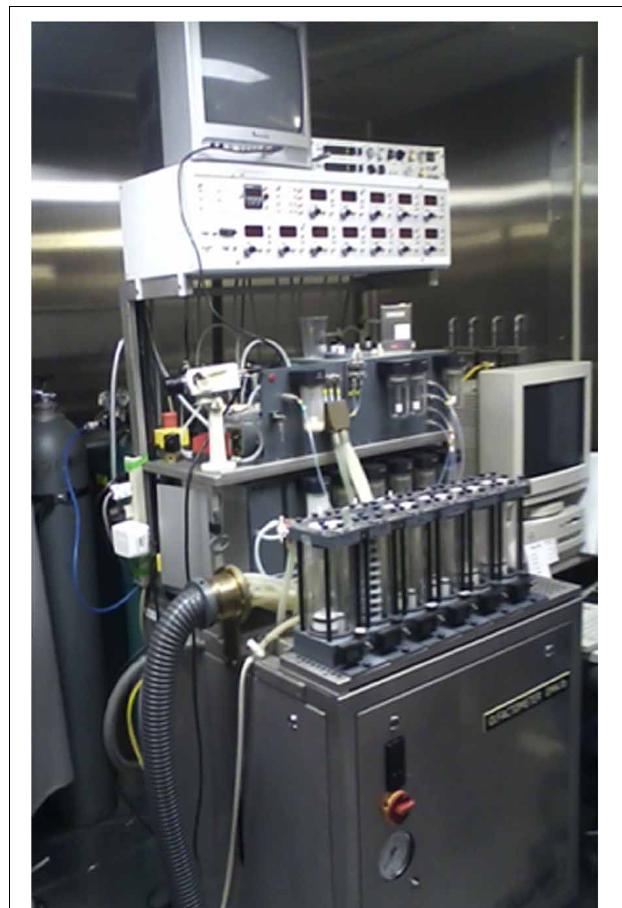
FIGURE 8 | Air-dilution olfactometer used to present pulses of odorants into a purified and humidified airstream directed through nares of a subject. This device ensures that the odor event-related potentials (OERPs) are not confounded by somatosensory artifacts due to alterations in stimulus pressure, temperature, or other factors. Photo courtesy of the University of Pennsylvania Smell and Taste Center, Philadelphia,